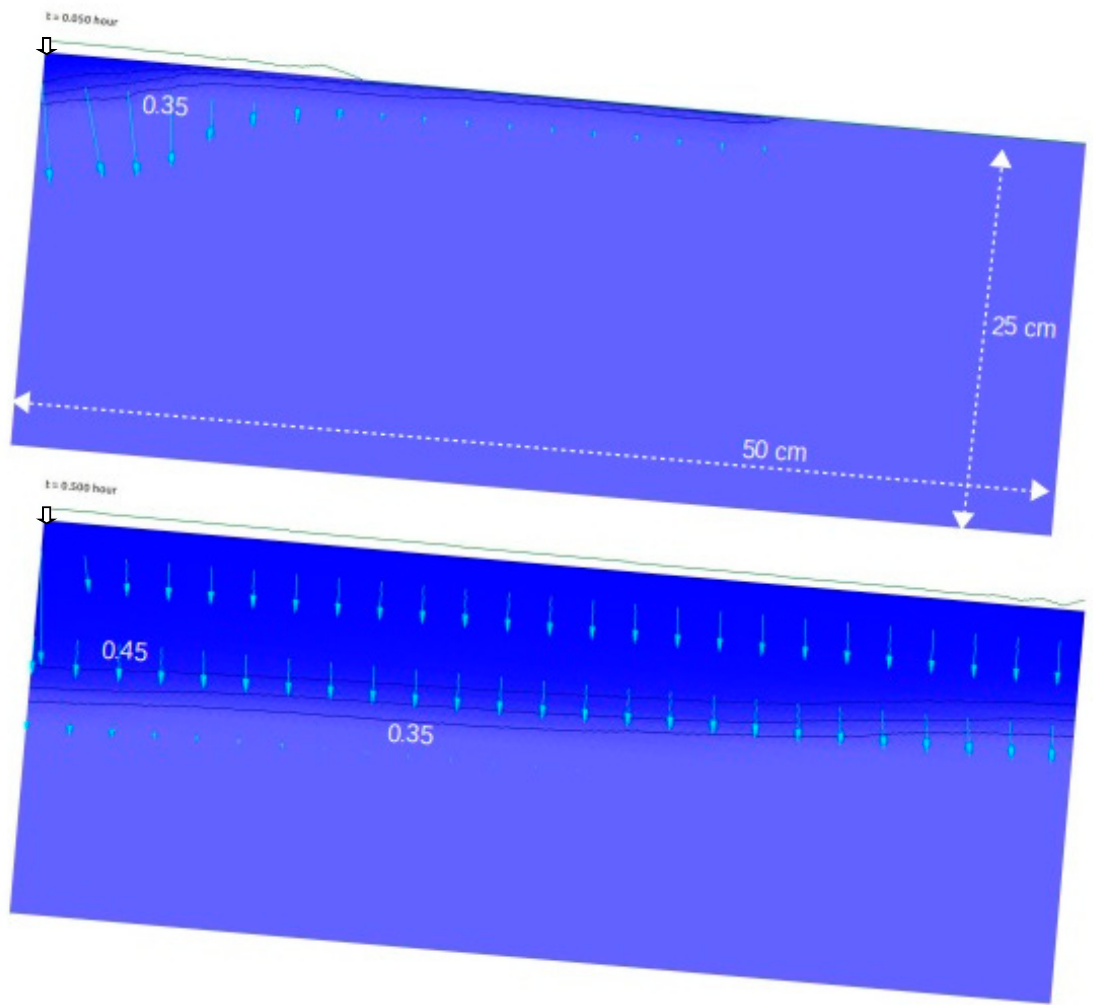
Figure 9. Flow simulation on loamy soil without sand ditch at t = 0.05 h (upper) and t = 0.5 h (lower) after initiation of inflow from the left upper edge at 3 cm/h ( ↆ ). Arrows show water flux with a scale of 1 (cm/h)/cm. Contour lines represent volumetric water content at 0.05 increment. Lime colored lines above the soil surface draw the height of standing water with 10 times zooming vertically.